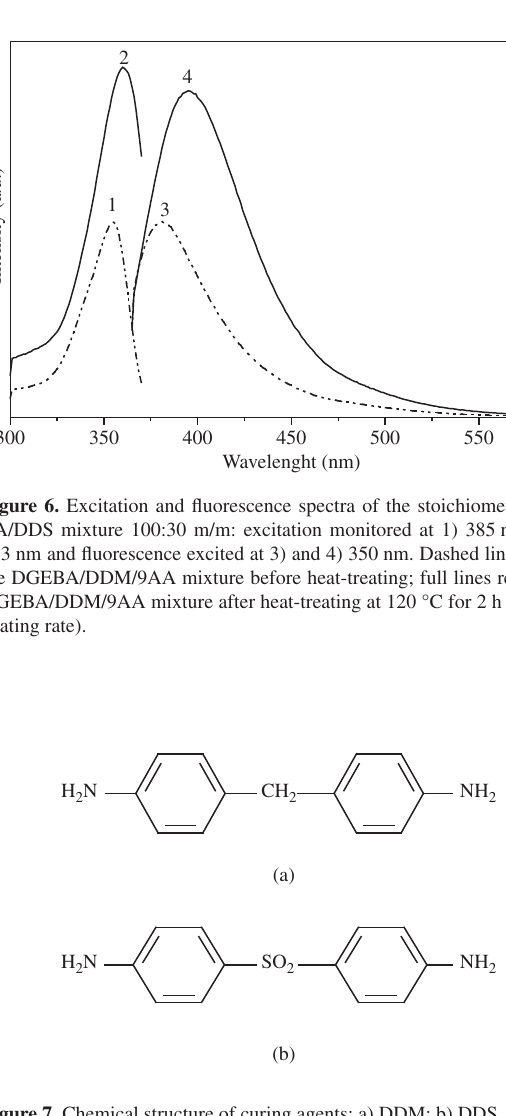
Figure 7. Chemical structure of curing agents: a) DDM; b)